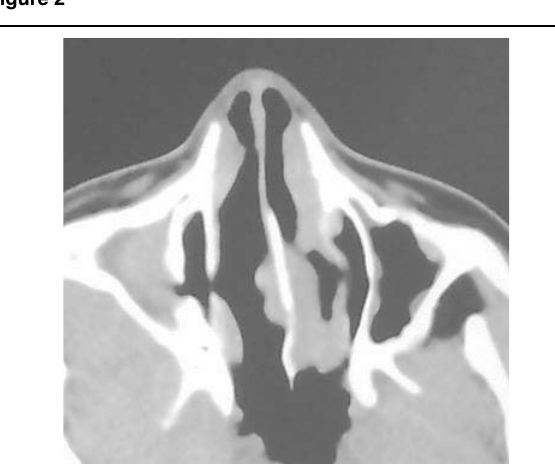
Axial computed tomography PNS showing unilateral maxillary affection by fungus .